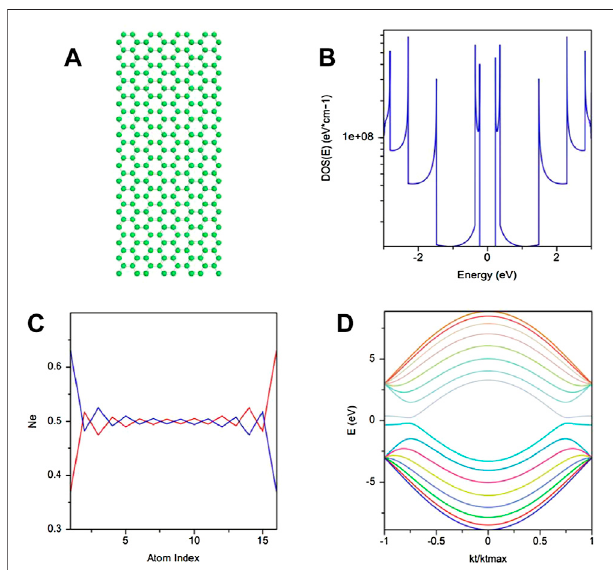
FIGURE 14 | When edge effects are considered, (A) GNR type-B with tight-binding energy (3 eV), c-c spacing (1.42 A ° ), chirality (8,8), (B) density of states plotted with energy, (C) spin resolved density with atom index, and (D) band structure. We have plotted these results from the nanohub software of Purdue University